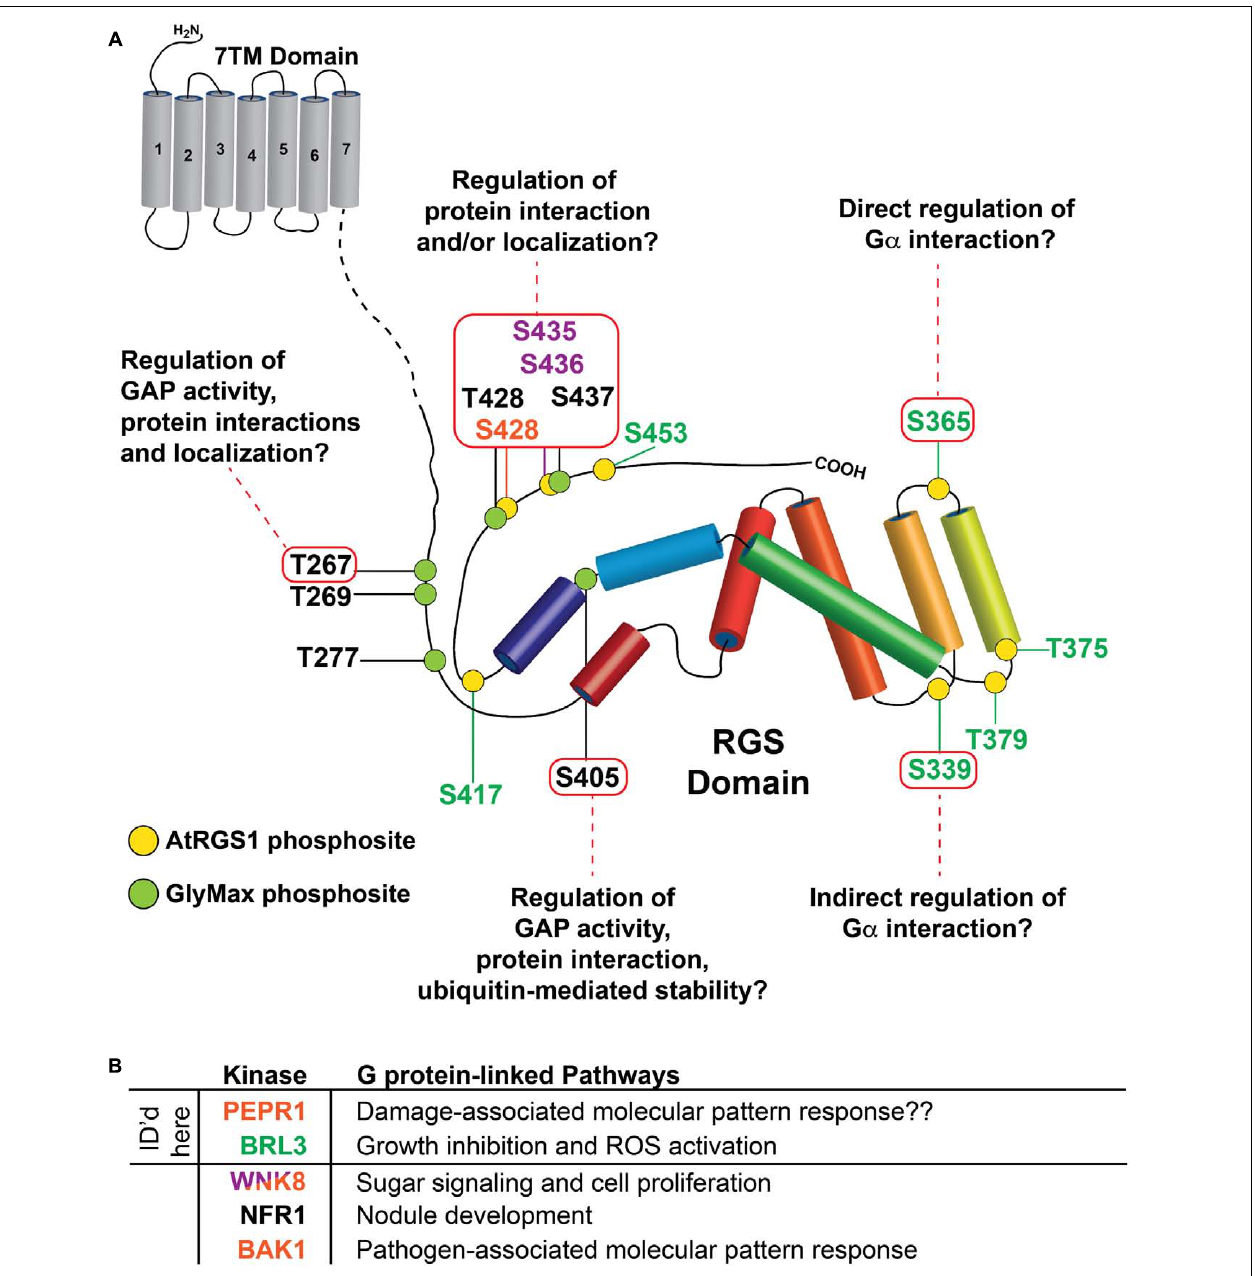
FIGURE 6 | Summary of potential functions for RLK targets on plant RGS proteins identified by SAPH-ire. (A) Potential functional roles of indicated phosphorylation sites (inside red boxes) were derived from SAPH-ire detection and analysis of co-aligned, sequence-neighboring, or structurally proximal phosphorylation sites with reported functional effects on mammalian RGS proteins. As in Figure 1 , phosphorylation sites identified in this study on AtRGS1 and GmRGS2 as well as sites identified previously are illustrated in the context of the domain architectures of AtRGS1 and GmRGS2 (yellow and green circles). Kinases are indicated by site ID color: BRL3 (green), BAK1, PEPR1, and WNK8 (orange) and WNK8 only (purple). NRF1 phosphorylation sites are indicated for GmRGS2 sites (black). Domain sizes are not to scale to emphasize the RGS domain and surrounding regions. (B) Table of kinases that phosphorylate AtRGS1 and GmRGS2 and the G protein-linked pathways in which they have been associated or are thought to be associated (indicated with “??”). Each kinase is color coded to match the phosphosites indicated in (A) , above. Kinases for which RGS phosphorylation sites were identified by mass spectrometry in this report are